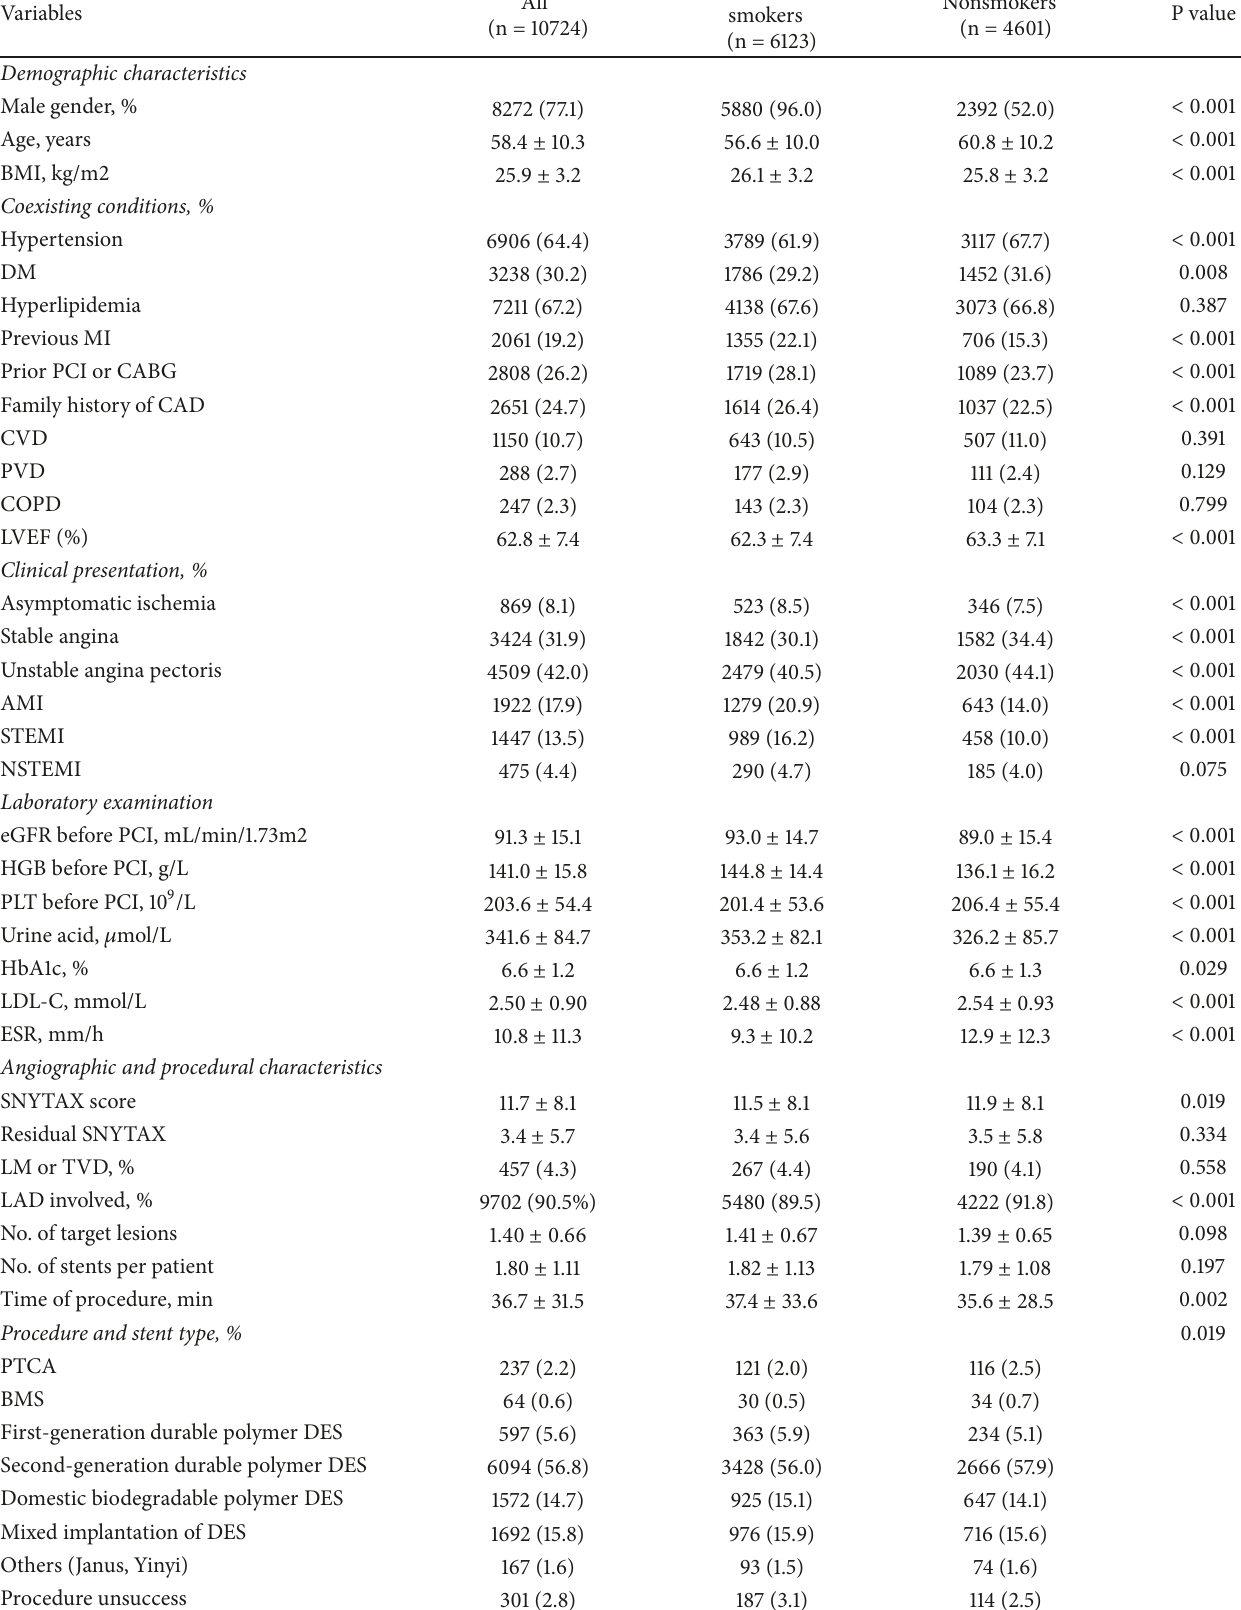
Table 1: The baseline clinical, angiographic, and procedural characteristics and medication